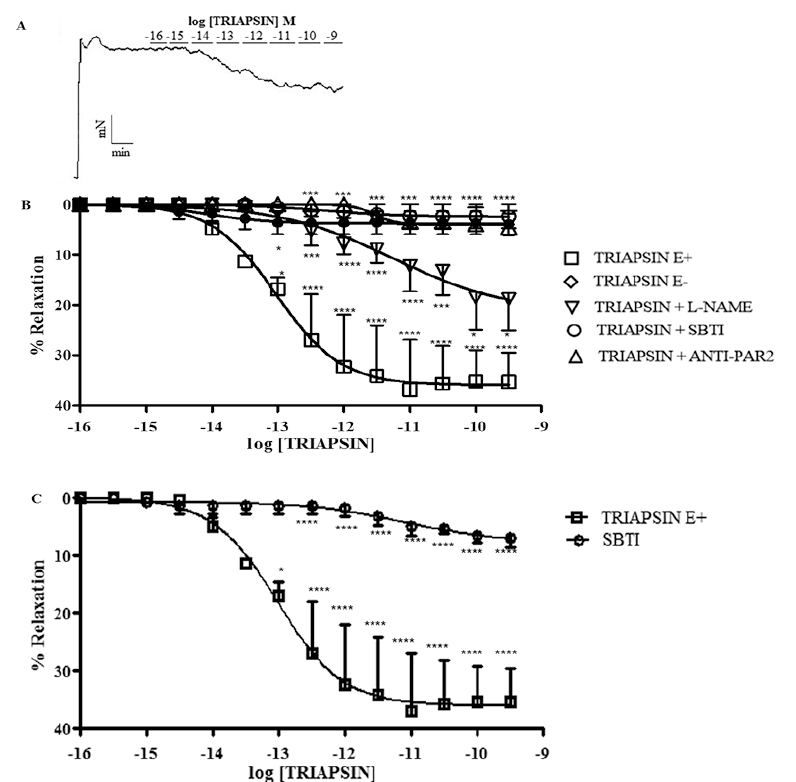
Figure 5. Triapsin induces relaxation of mouse mesenteric artery that is mediated by endothelial PAR-2. (A) Representative tracing depicting the concentration- dependent vasodilation effect of triapsin in endothelium-containing mesenteric arteries rings from Swiss mice pre-contracted with phenylephrine (3 µM). (B) Shows the mean ± S.E.M. of the vasodilation effect of triapsin in endothelium-containing vessels in the absence (triapsin E+) or in the presence of NOS inhibition (triapsin + L-NAME) or PAR-2 inhibition (triapsin + anti-PAR-2). The concentrations of L-NAME and anti-PAR used were 300 µM and 10 µg/mL, respectively. A control with the serine protease inhibitor SBTI (4 µM) was included. The requirement for an intact endothelium for triapsin-induced relaxation was tested in endothelium-denuded vessels (triapsin E - ). Two-way ANOVA with Bonferroni’s multiple comparisons test was used to analyze the differences. **p < 0.01; ***p < 0.001, ****p < 0.0001. diamond: triapsin E-; rectangle: triapsin E+; inverted triangle: triapsin + L-NAME; empty circle: triapsin + SBTI; triangle: triapsin + ANTI_ PAR2. ( C) Curves show mean ± S.E.M. of the vasodilation effect of triapsin in endothelium-containing vessels in the absence (rectangle) of SBTI and the effect of SBTI (circle). SBTI concentration was 4 µM. Two-way ANOVA with Bonferroni’s multiple comparisons test was used to analyze the differences. *p < 0.05; ****p <